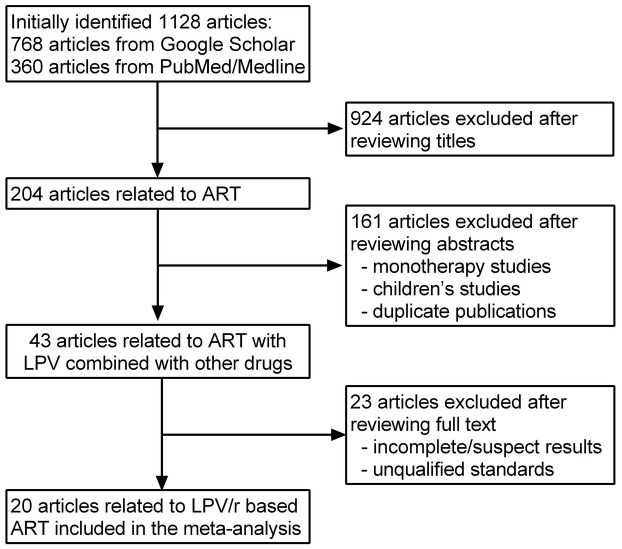
Flow diagram of the study selection process for the meta-analysis.